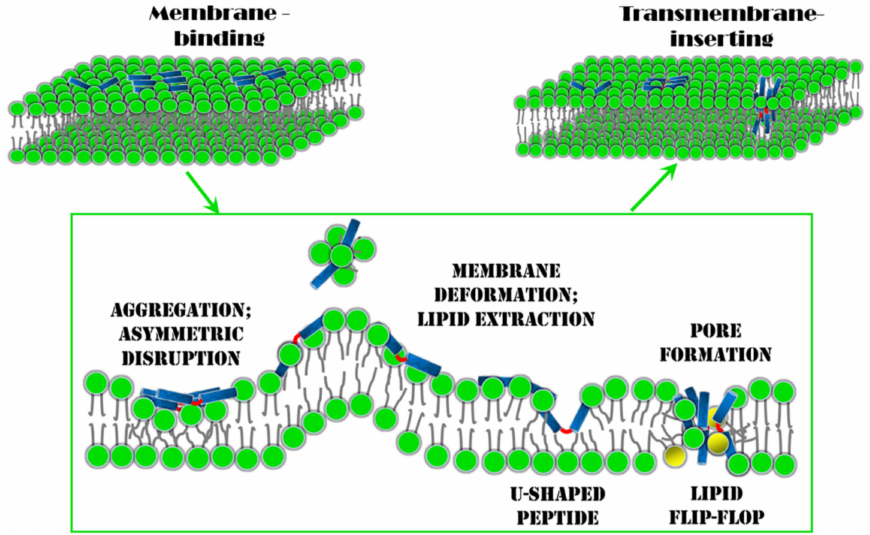
Figure 7. Diagrammatic sketch showing the membrane insertion process of melittin. Between the initial membrane-binding and final transmembrane-inserting states, aggregation and conformational changes occur to the peptides, leading to asymmetric disruption and lipid extraction of the membrane. All these issues are regarded as key factors determining the membrane insertion of melittin. Melittin is represented with two blue rods connected by a red line. Lipids are shown with green heads and dark grey